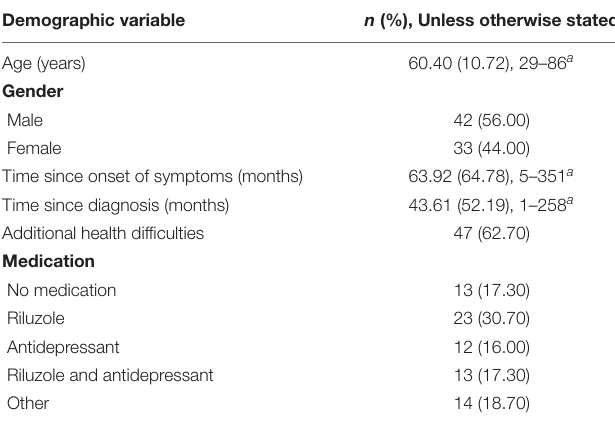
TABLE 1 | Demographic data ( n =